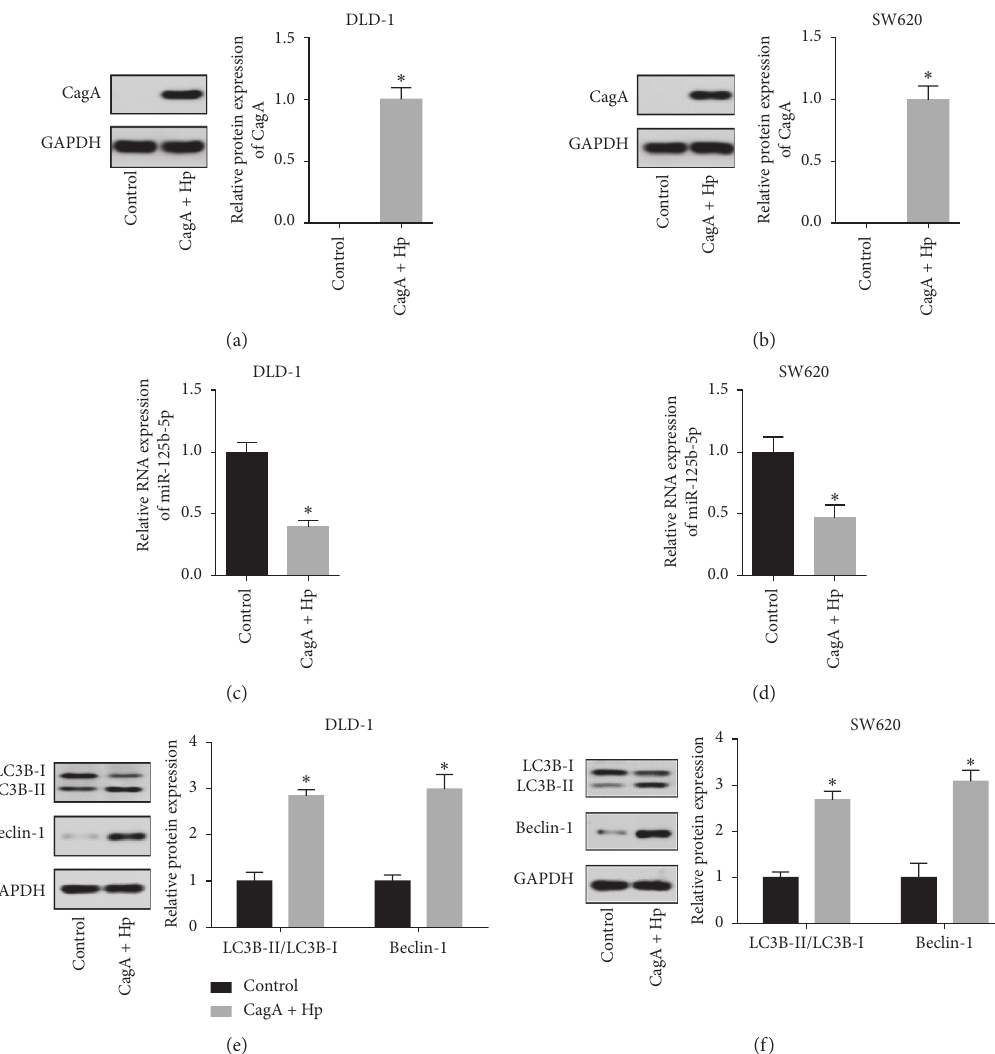
Figure 1: H. pylori (CagA+) inhibits miR-125b-5p and promotes LC3B-II/LC3B-I and Beclin-1 in colon cancer cells. (a) and (b) represent CagA protein expression was significantly increased after coculture of both the DLD-1 (a) and SW620 (b) colon cancer cell lines with H. pylori (CagA+). (c) and (d) represent that, after coculture with H. pylori (CagA+), miR-125b-5p expression was significantly decreased in both DLD-1 (c) and SW620 (d) cells. (e) and (f) represent the expression of the autophagy-related proteins LC3B-II/LC3B-I and Beclin-1 was significantly higher than that in the control group for both DLD-1 (e) and SW620 (f) cells. ∗ p < 0 .